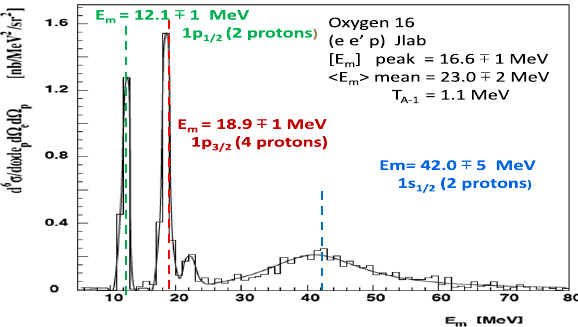
Fig. 7 The spectral function for 16 k = 60 MeV / c measured in Jlab Hall A [48–50] with 2.4 GeV incident electrons